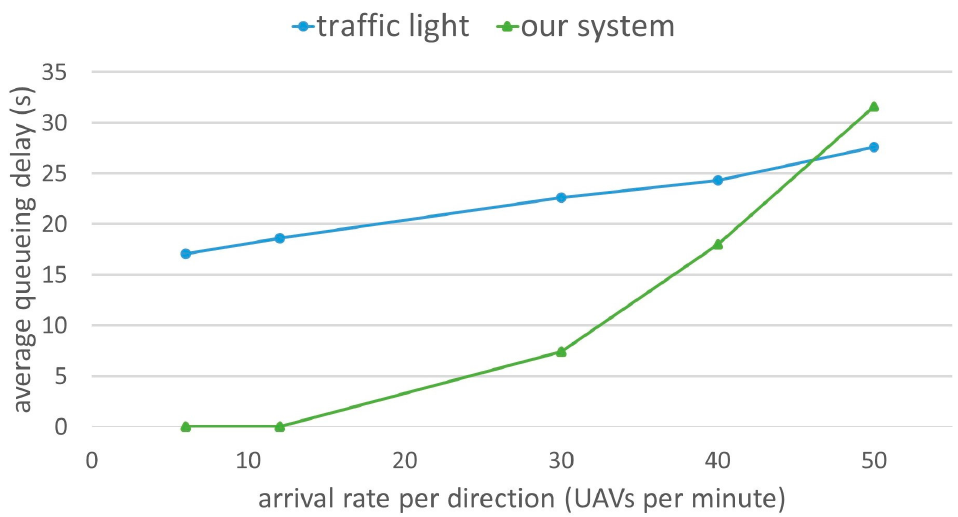
Figure 28. Average queueing delay of the UAVs using 2D optimal static traffic light and using our proposed system in 2D intersection on Scenario 2.